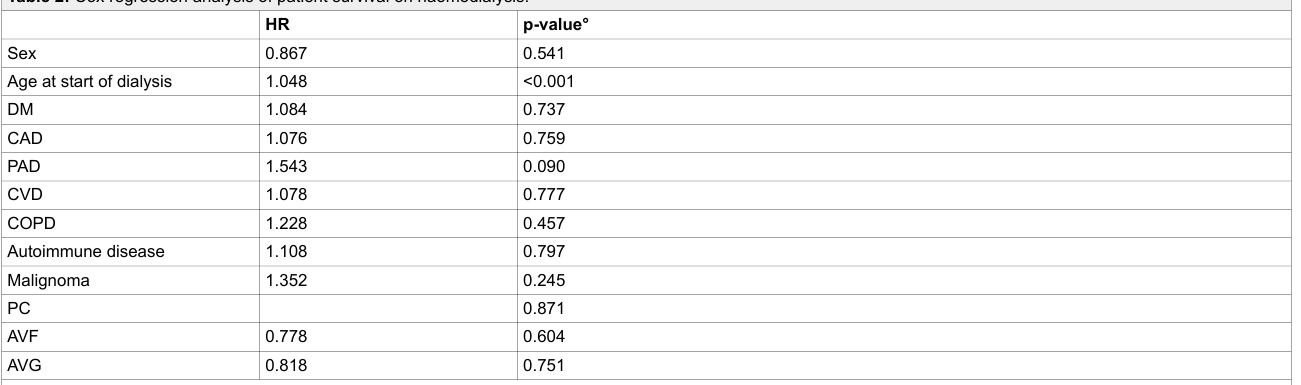
Table 2: Cox regression analysis of patient survival on